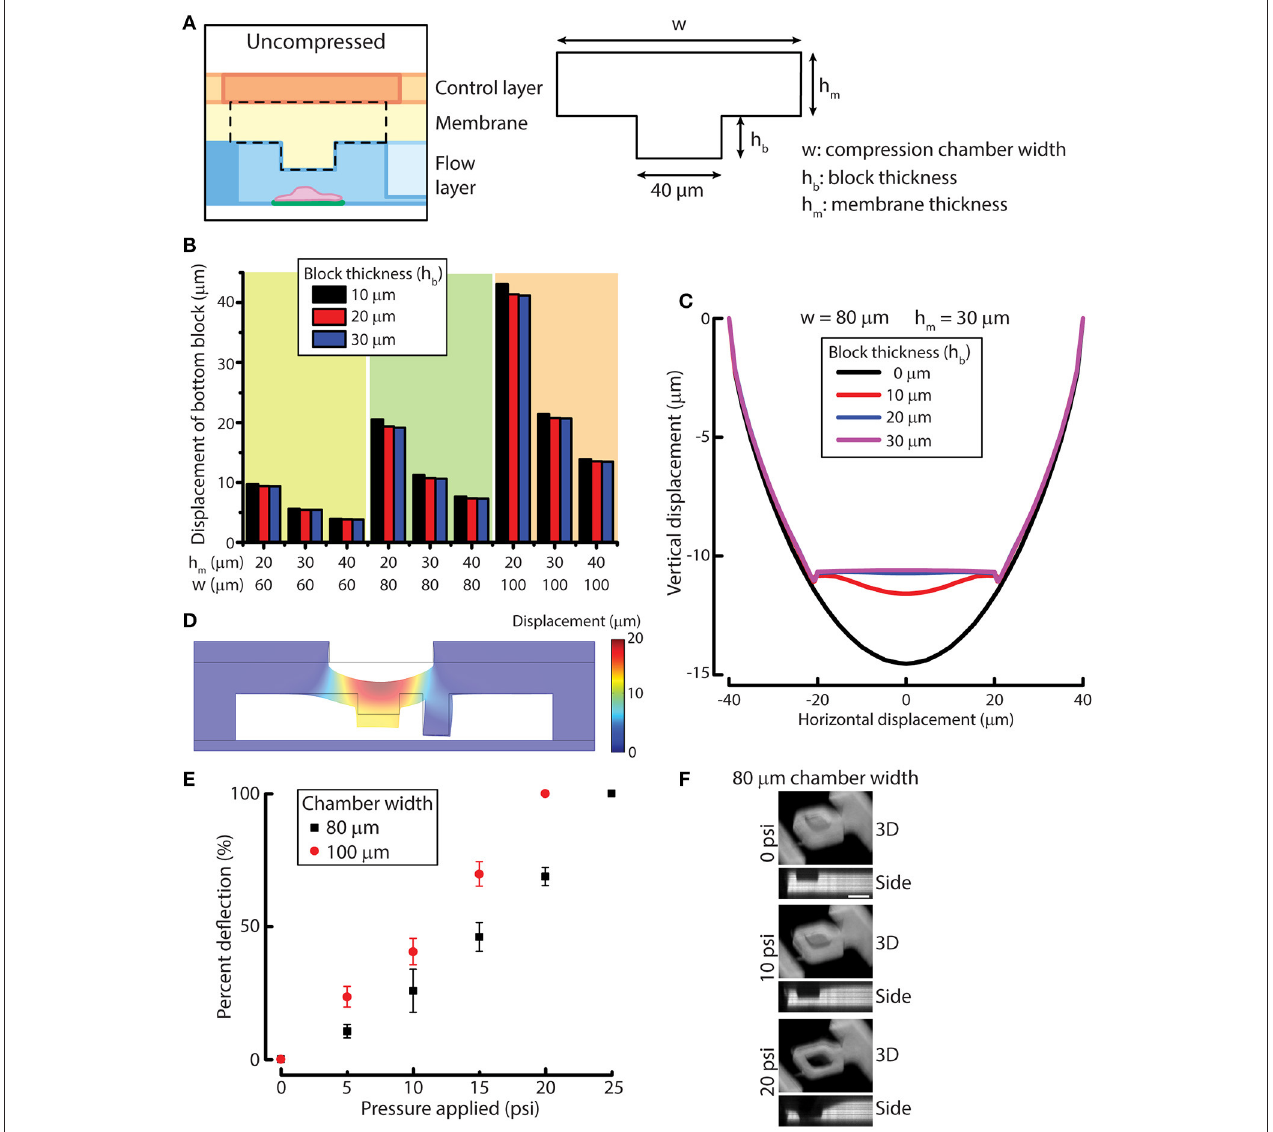
FIGURE 2 | Simulation and experimental results for designing and verifying the PDMS membrane block design of the device for cell compression. (A) A simplified model of membrane and block for simulation. Three geometric parameters were defined: compression chamber width ( w ), block thickness ( h b ) and membrane thickness ( h m ). (B) Displacement of the simplified membrane and block model at different values of geometric parameters. (C) Vertical displacement of the membrane and block at different horizontal positions across the compression chamber with different block thicknesses. (D) Displacement of the simulated result for the complete device model. (E) Membrane deflection of different compression chamber widths as a function of applied pressure. n = 3 for each chamber width. Error bar denotes the standard error of mean. (F) Reconstructed 3D and side view images of 80 µ m chamber width at different compression control valve pressures. Scale bar = 40 µ m.